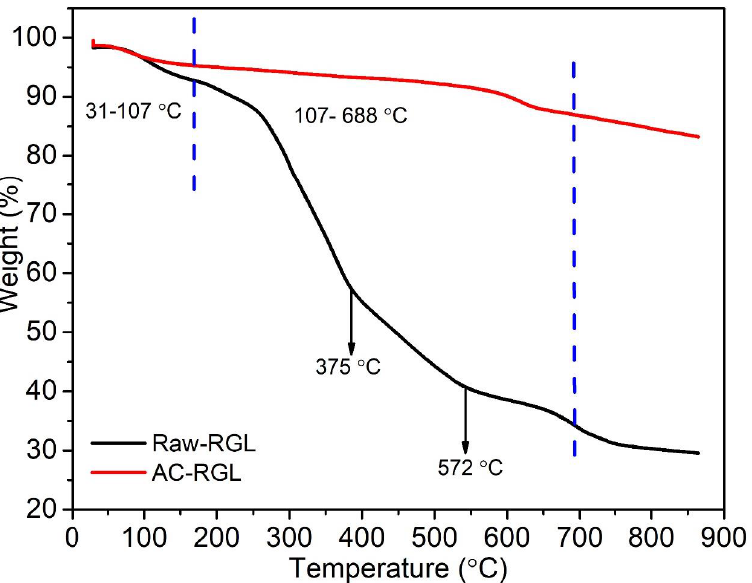
Figure 1. TGA plots of Raw-RGL and AC-RGL adsorbents. The first blue dotted line represent stage 1 which is from the beginning of the graph and end on the blue line, the second stage is the middle of the two blue lines and the third stage is to right after the second blue dotted line.